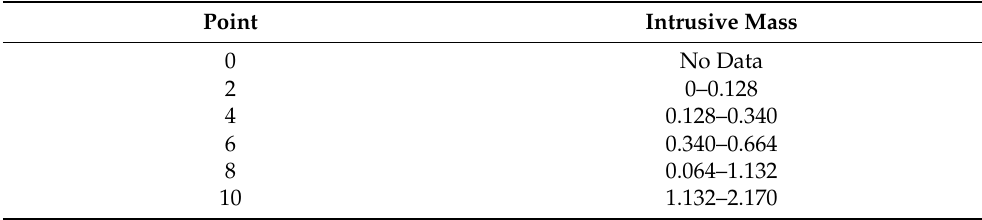
Figure 10. Potential map for the study area derived from the fuzzy logic model. High potential zones ( A – C ) are delimited by red lines. The yellow dots are the locations of mineralization that were documented and visited in the field survey. Table 3. Lineament density layer classification for fusing by multi-class index overlap